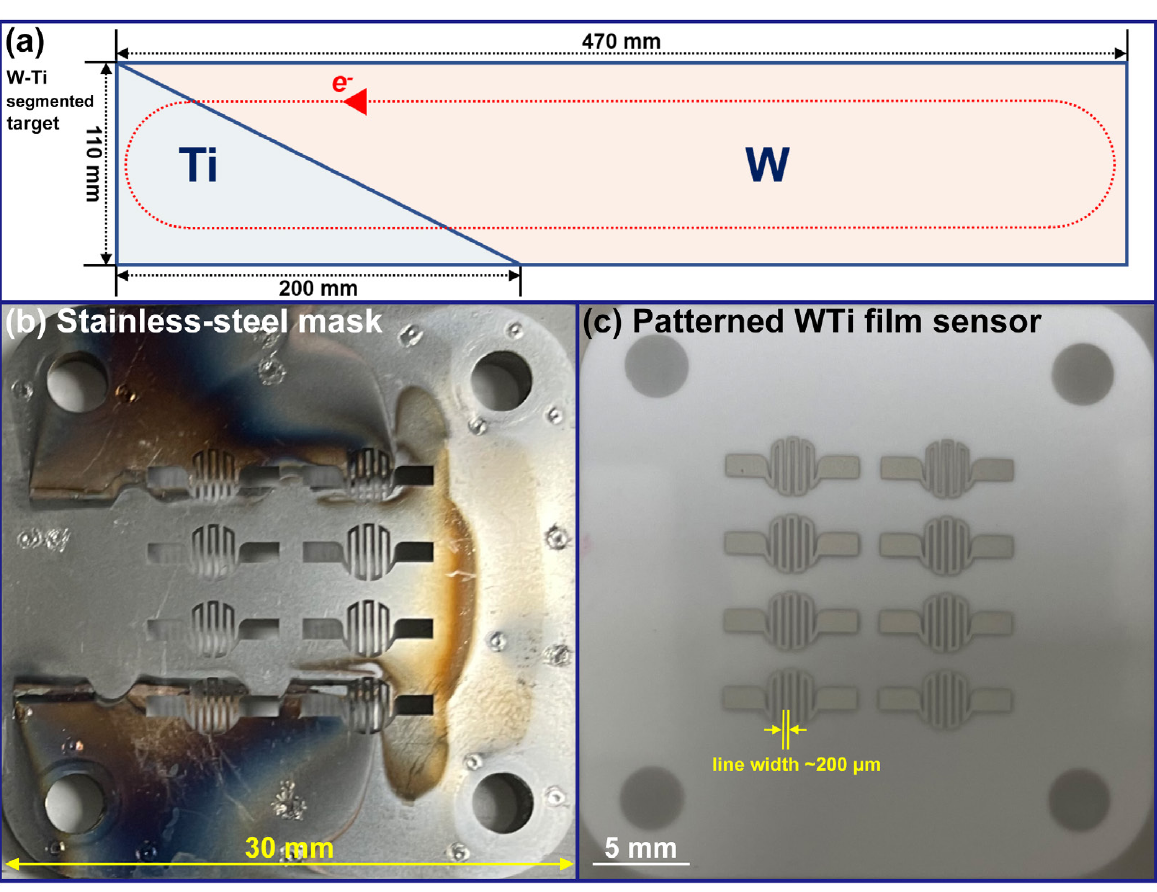
Figure 1. ( a ) Schematic diagram of the W-Ti segmented target, ( b ) image of the stainless-steel mask using for the WTi film deposition, and ( c ) image of the patterned WTi alloy film sensor.